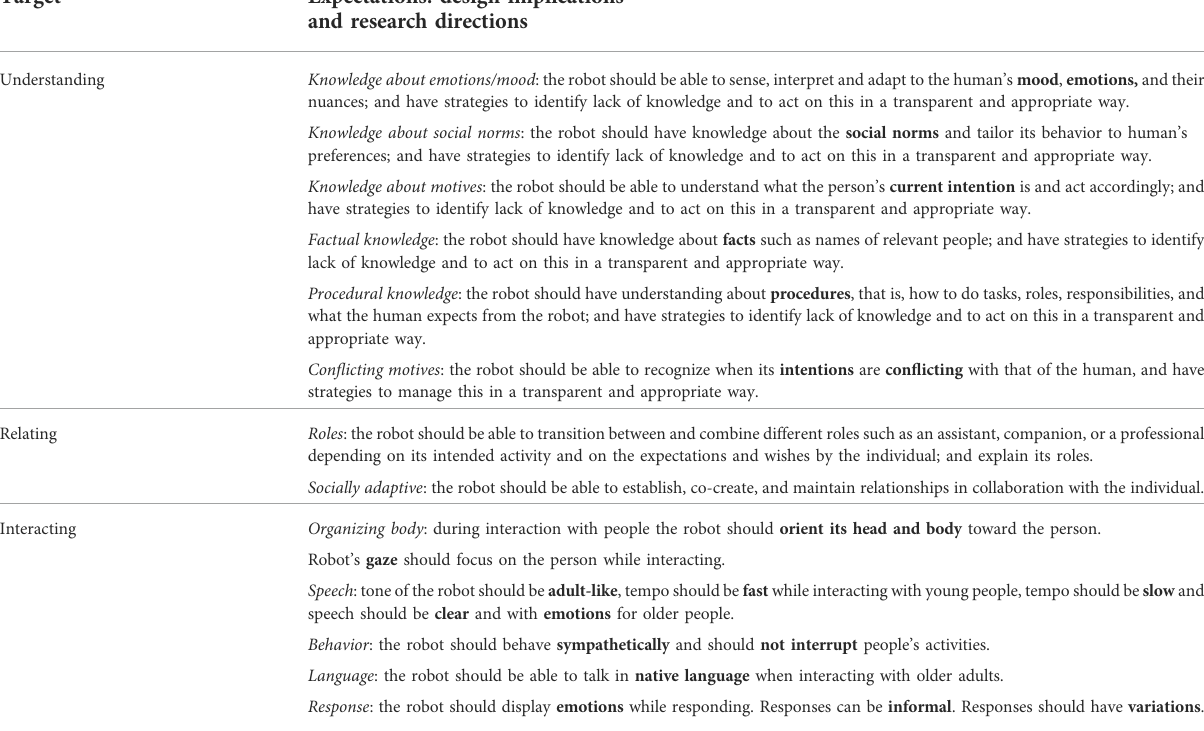
TABLE 6 Overview of expectations, sorted following the themes understanding, relating, and interacting. These expectations can also be viewed as design implications and research directions. The highlighted words indicate the attribute to be focused. Target Expectations: design implications and research directions